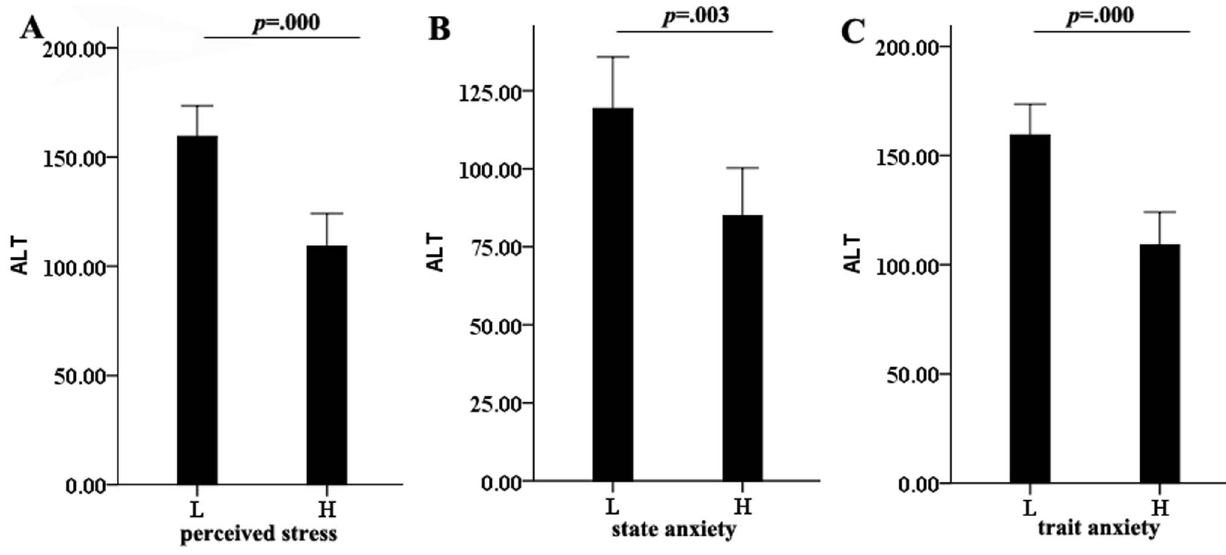
Figure 1. ALT level negatively associated with stress and anxiety. (A)Comparison of ALT between high and low perceived stress group; (B) Comparison of ALT between high and low state anxiety; (C) Comparison of ALT between high and low trait anxiety. P value was indicated.